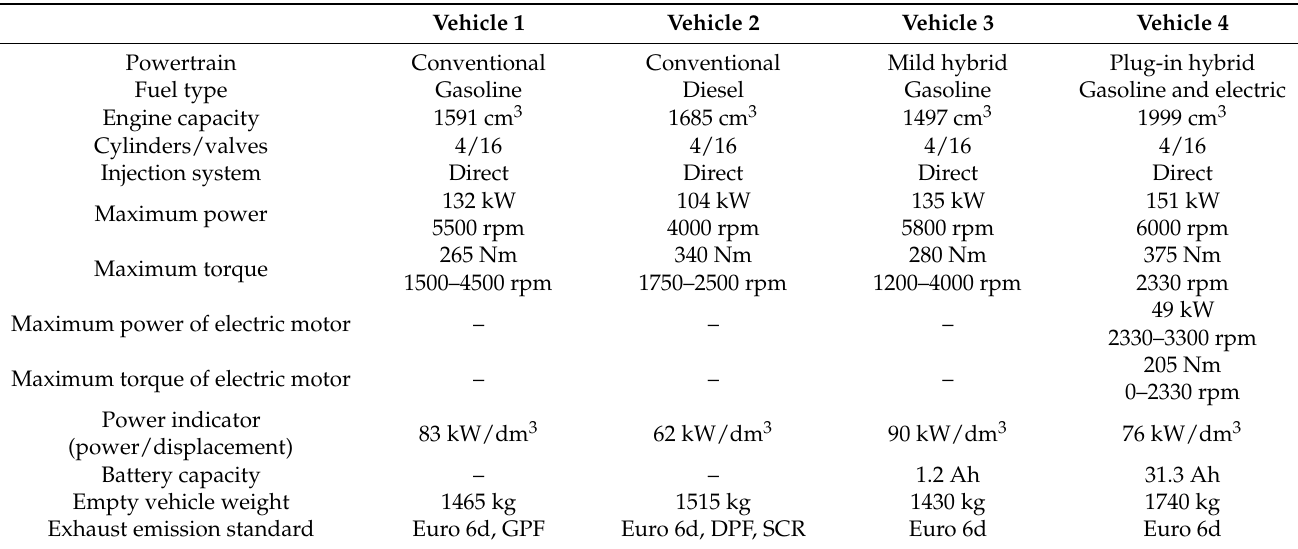
Table 1. Selected technical data of research objects. Vehicle